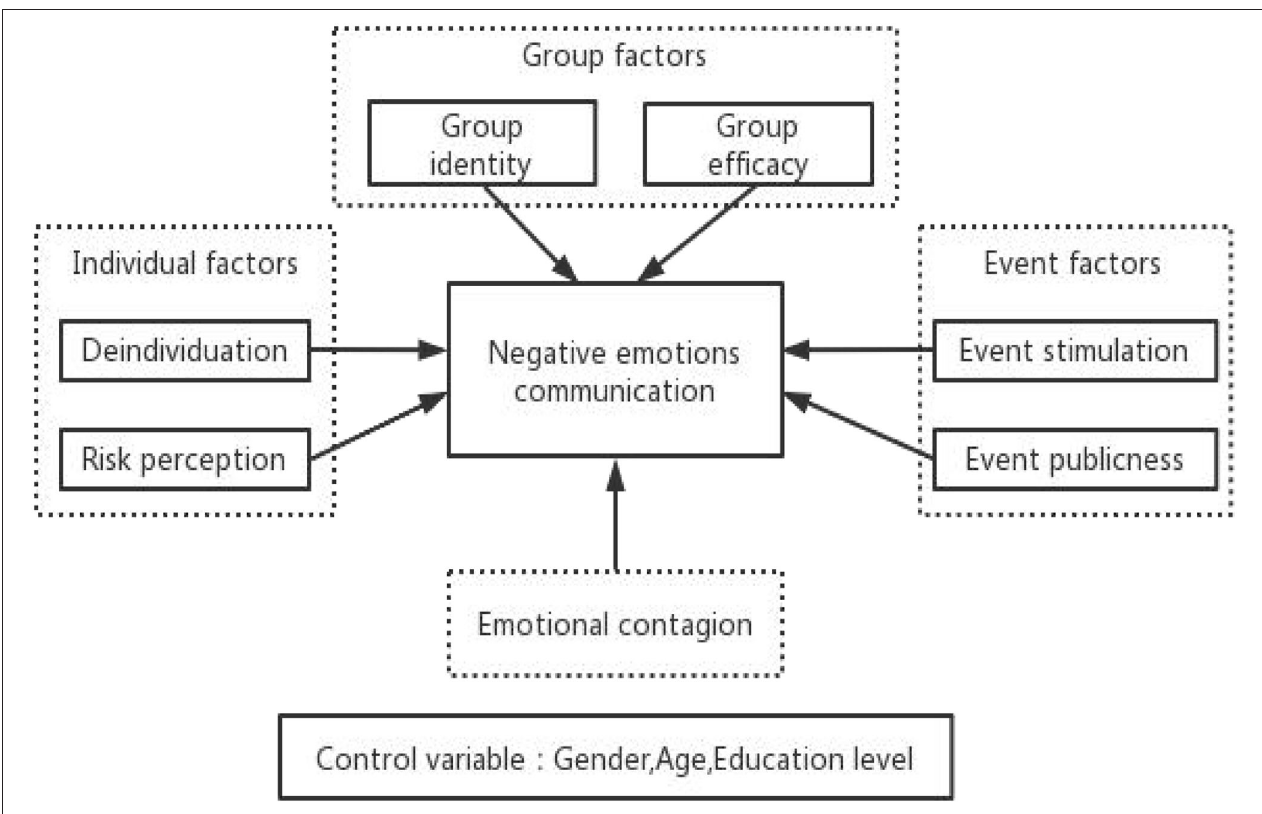
FIGURE 1 | Hypothesis